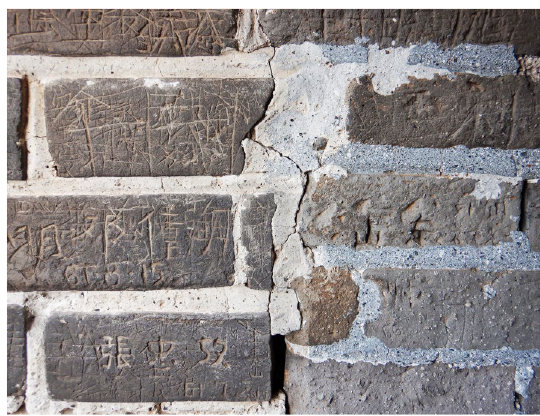
Fig. 12 Different stages of restoration during the Ming Dynasty. The largest joint width is approximately 2 cm. Left: earlier Ming Dynasty. Right: later stage (Source: